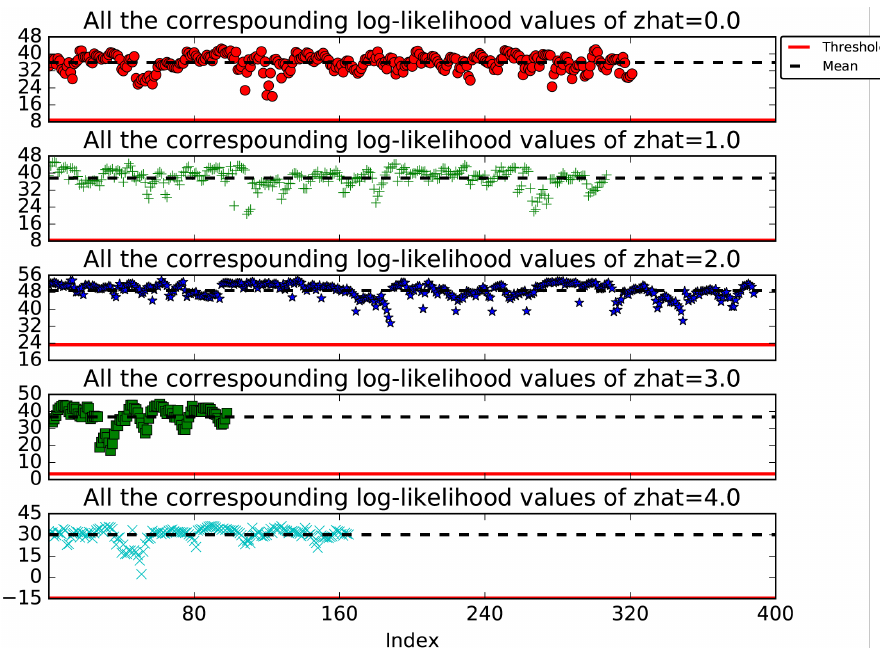
Figure 8. All the log-likelihood values of individual hidden state of Skill 3 when the truncation states number is set to K = 5. Each subplot shows the mean value (black dotted line) and the corresponding log-likelihood threshold value (red solid line) in Equation